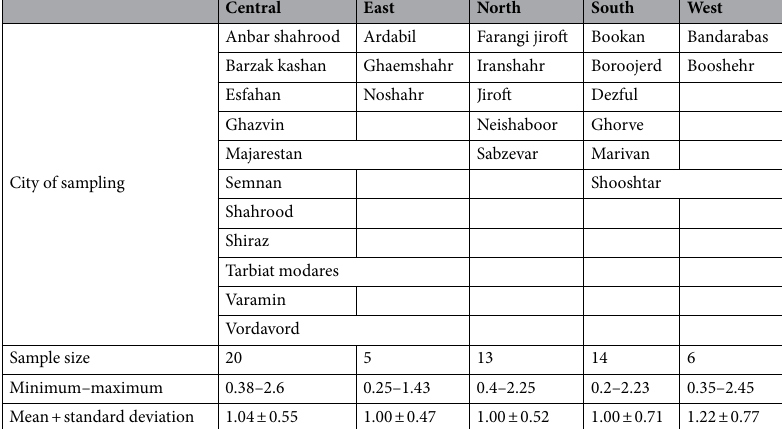
Table 1. Description of origin of spearmint samples and EO